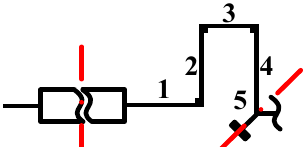
Figure 7. The further simplified model for optimal N-shaped beam design. We presuppose the parameters of the N-shaped beams on both sides of the symmetric axes are exactly the same.